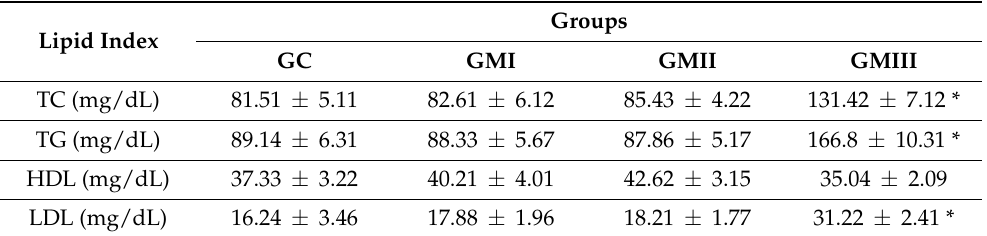
Values are expressed as the mean ± standard deviation (mean ± SD). ( n = 10). * Significant difference with respect to the control group at p ≤ 0.05 (ANOVA) with Duncan’s multiple range